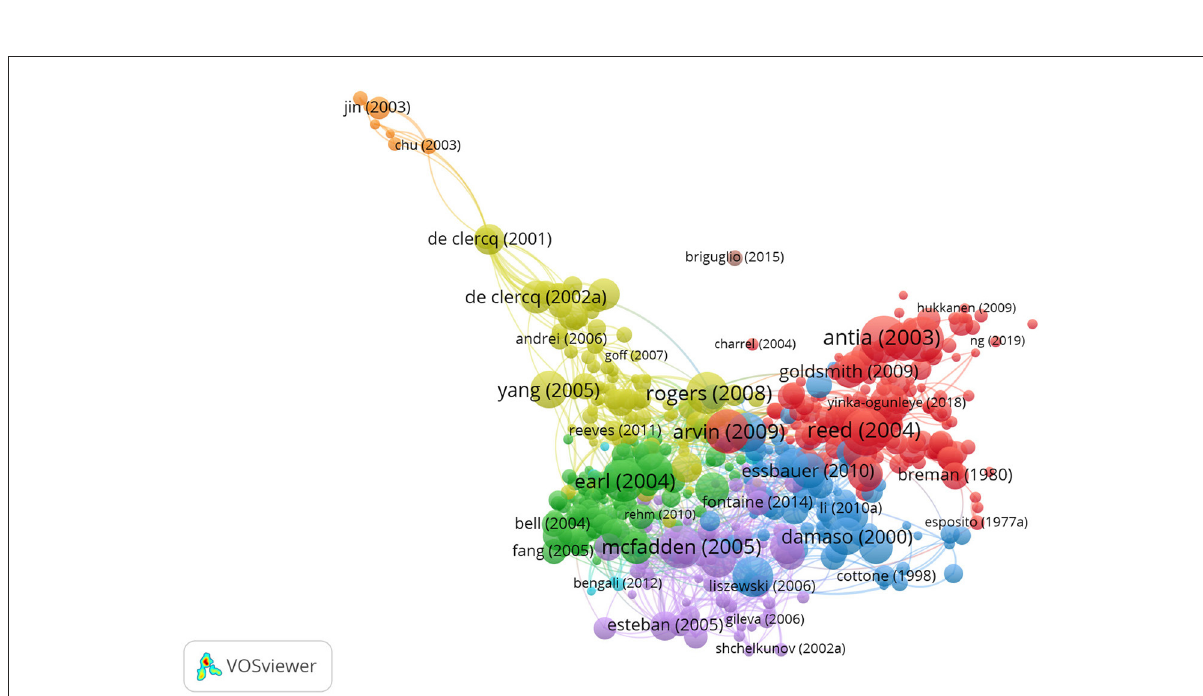
FIGURE10 Bibliographic coupling of documents in the monkeypox research. The minimum number of related documents was set to 10, and eight clusters were obtained from the analysis.